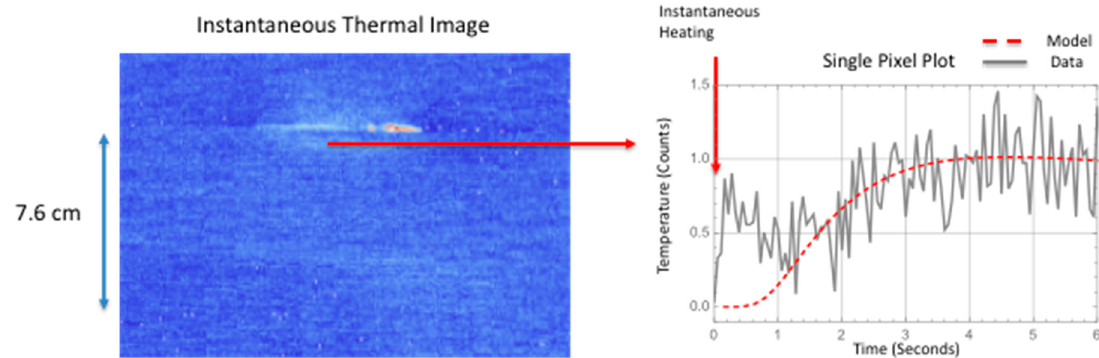
Figure 16. Temporal pixel plot comparison to model response for flaw source buried at 0.258 cm.